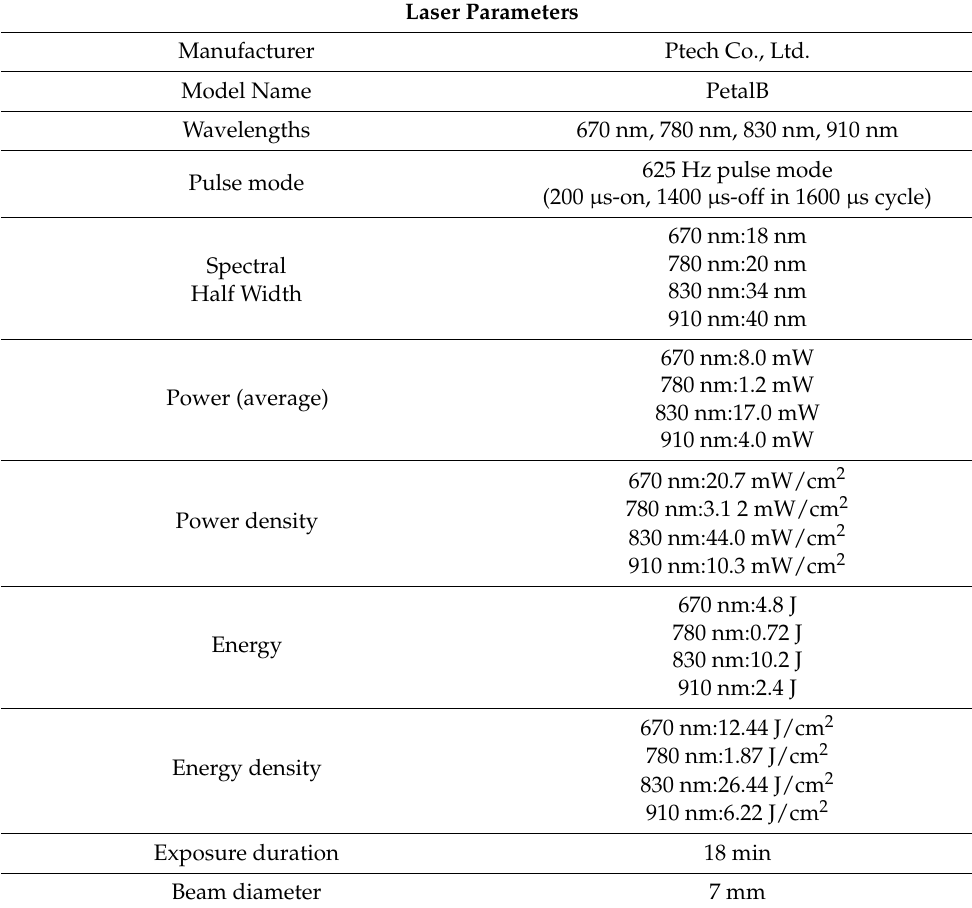
Table 2. Laser therapy